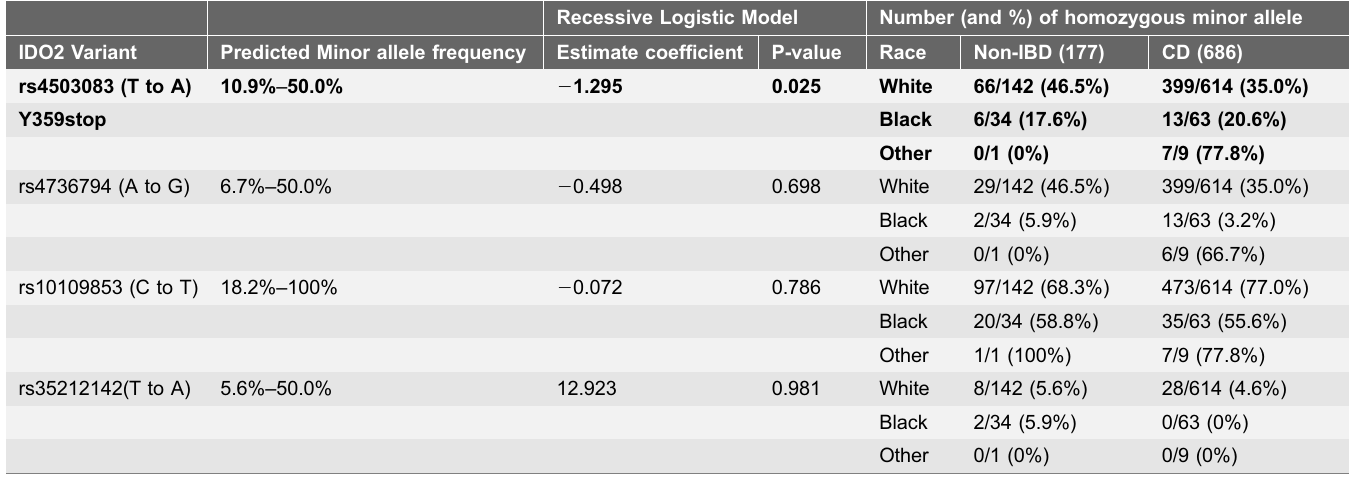
Table 2. Expected and identified frequency of patients with IDO2 Variant